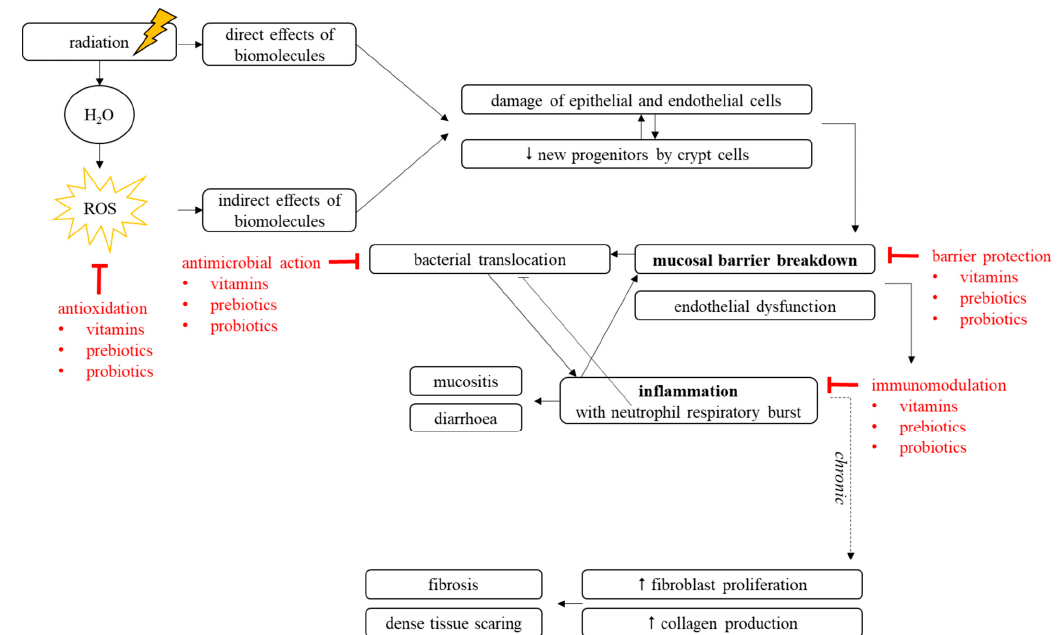
Figure 1. Scheme of radiotherapy inducing interactions between epithelial and endothelial radiation injuries in the gastrointestinal tract resulting in acute events and late tissue fibrosis.